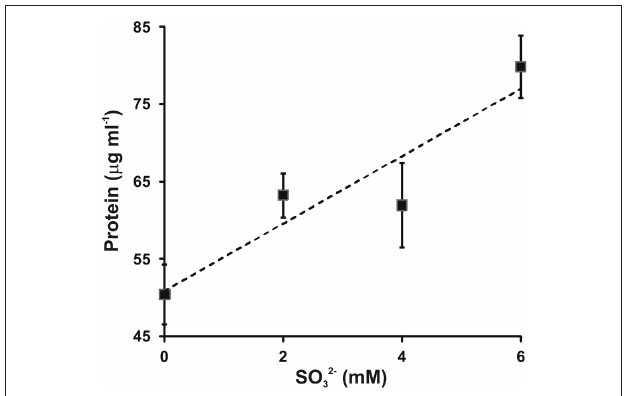
FiGurE 5 | A comparison of sulfite pools in wild type and mutant strains of C. tepidum . Cells were grown in medium containing sulfide + thiosulfate and harvested during logarithmic growth phase. The values presented are the means of three independent cultures ± SE. Measurement of internal (dark bars) and external (light bars) pools is described in Section “Quantification of